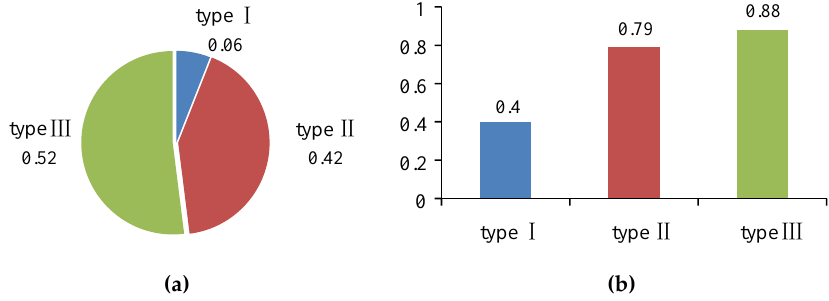
Figure 10. Details of different cluster types. ( a ) The proportion of different types; ( b ) The precision of different types. Table 3 . Results of different cluster algorithms for Dataset 3.